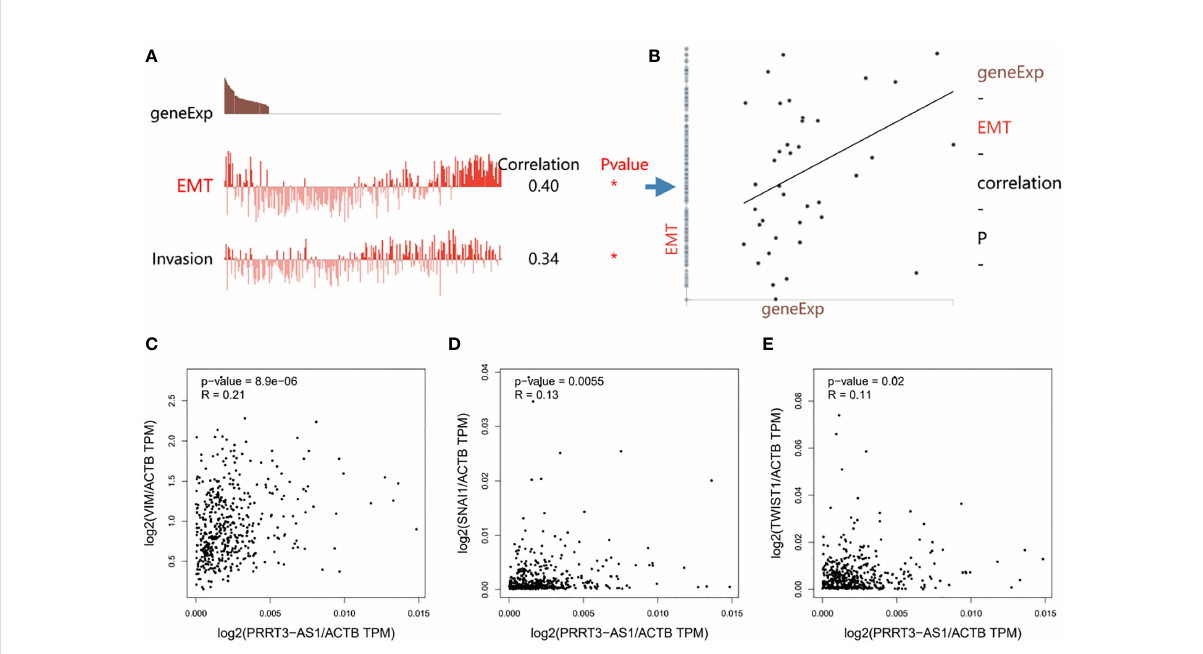
FIGURE 5 Functional relevance of PRRT3-AS1 in CancerSEA database. (A) Functional relevance of PRRT3-AS1 in melanoma. (B) Correlation between PRRT3-AS1 expression and EMT. The relation of PRRT3-AS1 expression and EMT-related genes VIM (C) , SNAI1 (D) , and TWIST1 (E) . * P <